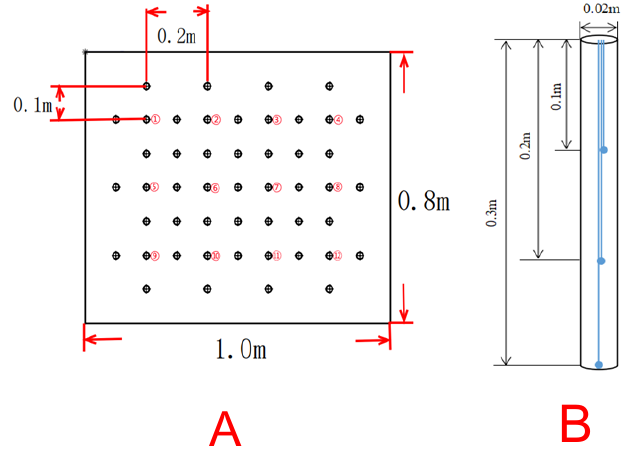
Figure 2. Distribution of the drilling positions. The red points are the heater’s locations, and the black points are the thermometer locations. ( A ) diagram of the top plan of the rock mass experiment; ( B ) distribution chart of temperature monitoring points.